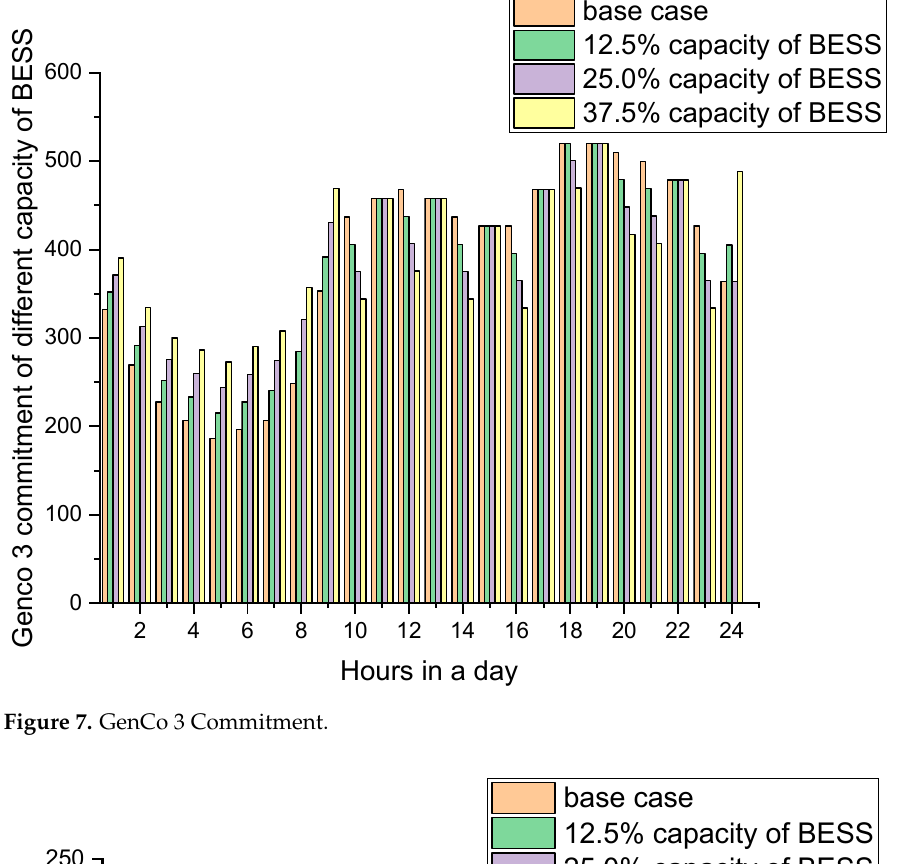
Figure 6. LMP of Bus 3.